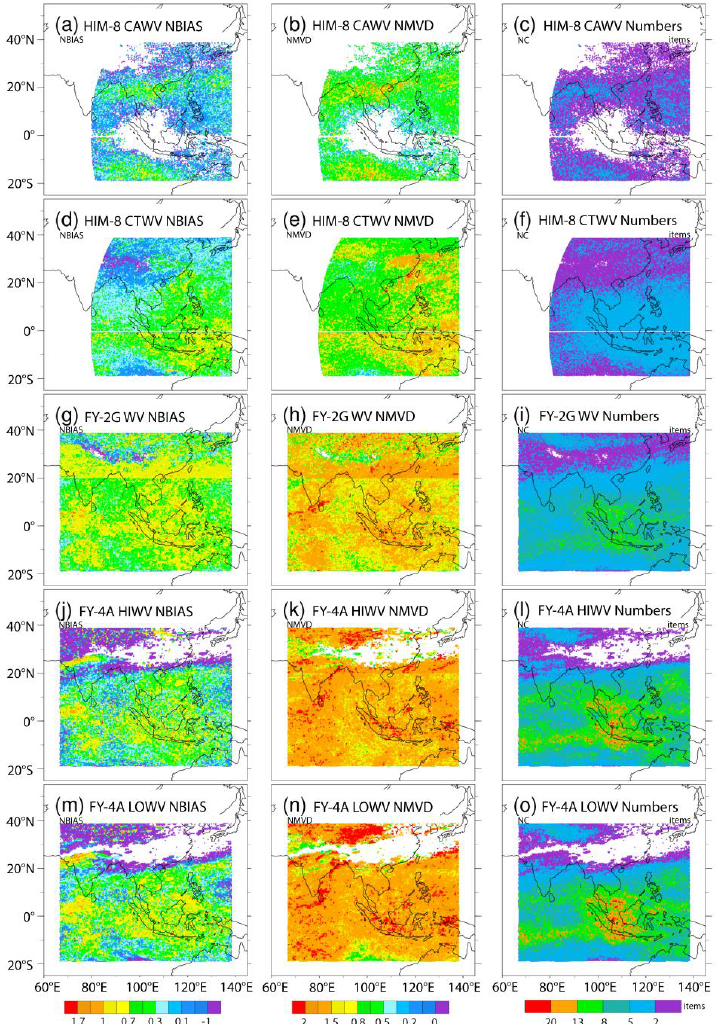
Figure 12. The spatial pattern plots of normalized mean vector differences (NMVD), normalized speed bias (NBIAS) and the number of collocations in the high-level averaged for ( a – c ) CAWV from HIMA-8, ( d – f ) CTWV from HIMA-8, ( g – i ) WV from FY-2G, ( j – l ) HIWV from FY-4A, and ( m – o ) LOWV from FY-4A, respectively, in December 2018 when WV AMVs from FY-2G, FY-4A, and HIMA-8 were collocated with the NCEP FNL wind